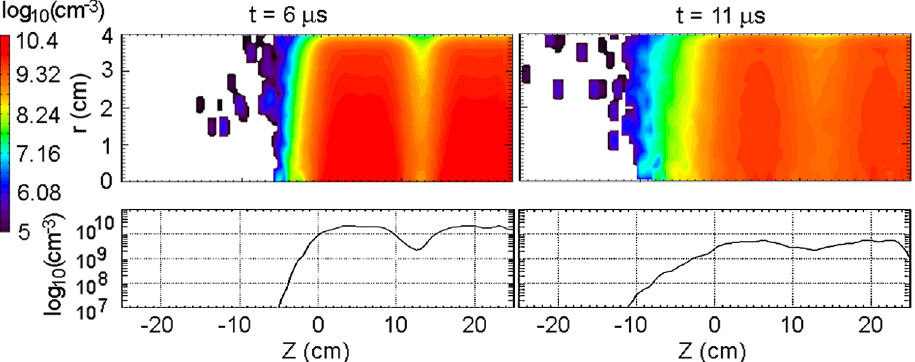
FIG. 15. (Color) n axial slices at r (cid:6) 0 (bottom) and f r; z g isocontours through (cid:3) (cid:6) (cid:2) (top) at t (cid:6) 6 (cid:1) s (left) and t (cid:6) 11 (cid:1) s (right). p Because of space charge, the radially directed injection velocities, and the lack of magnetic guide field, electron populations do not axially move a significant distance. The plots are on log 10